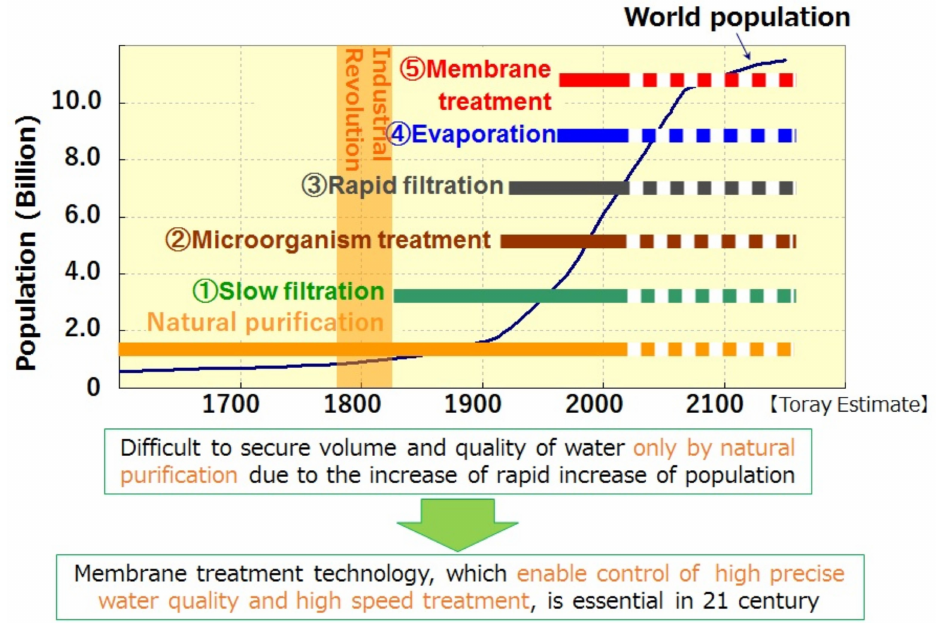
Figure 1. Increase of world population and development of water treatment technologies [2].